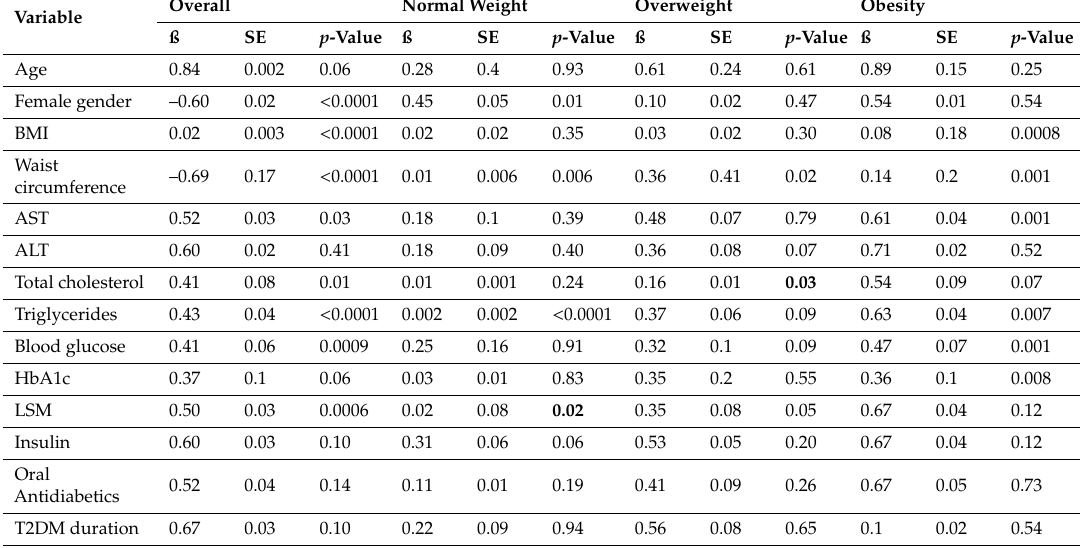
Table 3. Univariate analysis of factors associated with severe